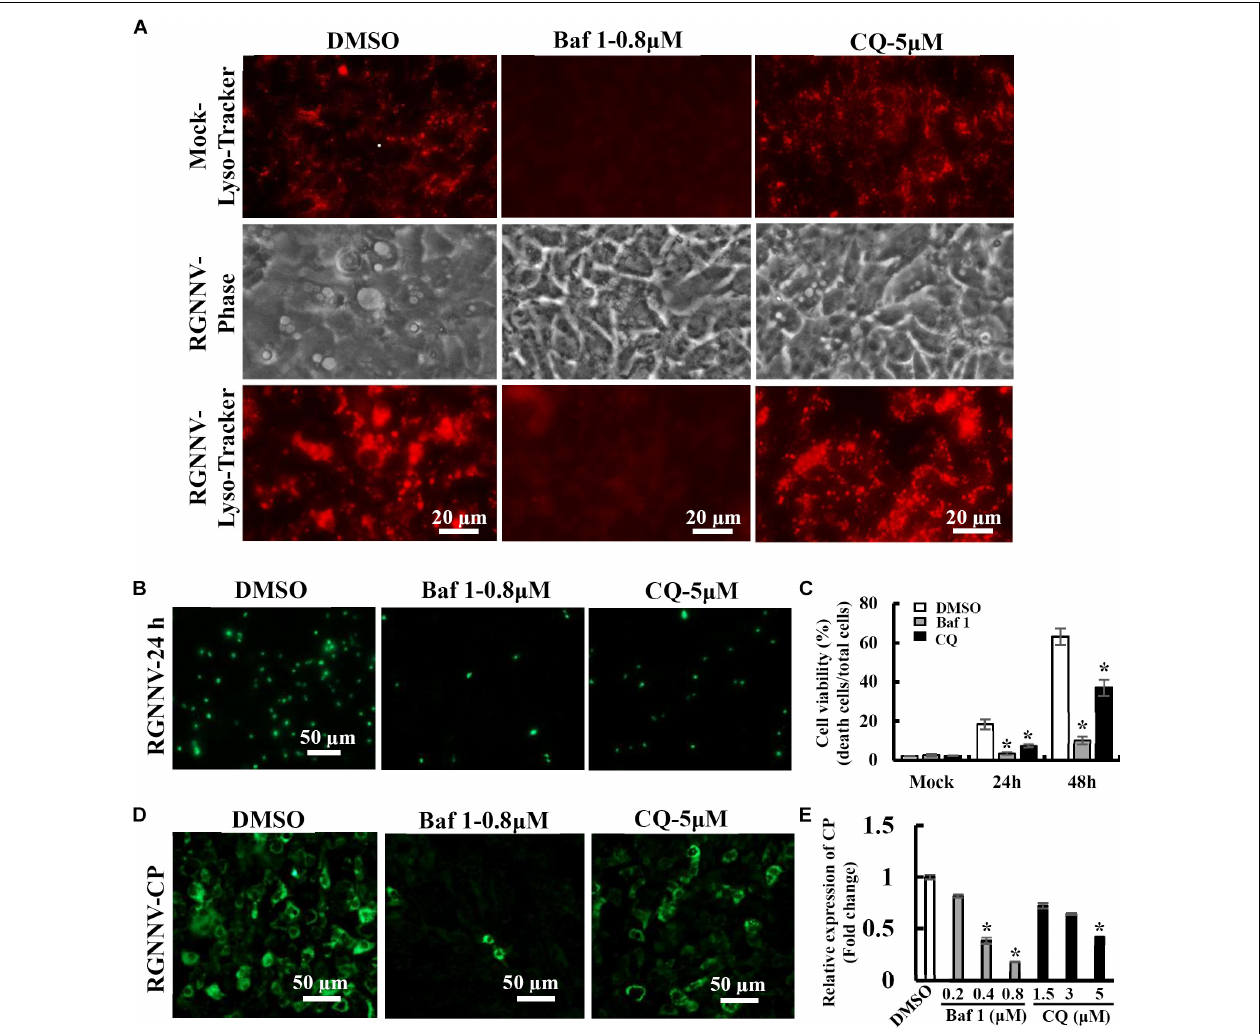
FIGURE 5 | Vacuole formation and viral replication during RGNNV infection were dependent on lysosomal acidification. (A) The effects of bafilomycin A1 and CQ on lysosome morphology and vacuole formation. (B) The effect of bafilomycin A1 and CQ on RGNNV infection-induced cell death. (C) The percentage of cell death in RGNNV-infected cells following treatment with bafilomycin A1 or CQ. (D) Treatment with bafilomycin A1 or CQ significantly inhibited viral protein synthesis. (E) Quantitative analysis of RGNNV CP viral